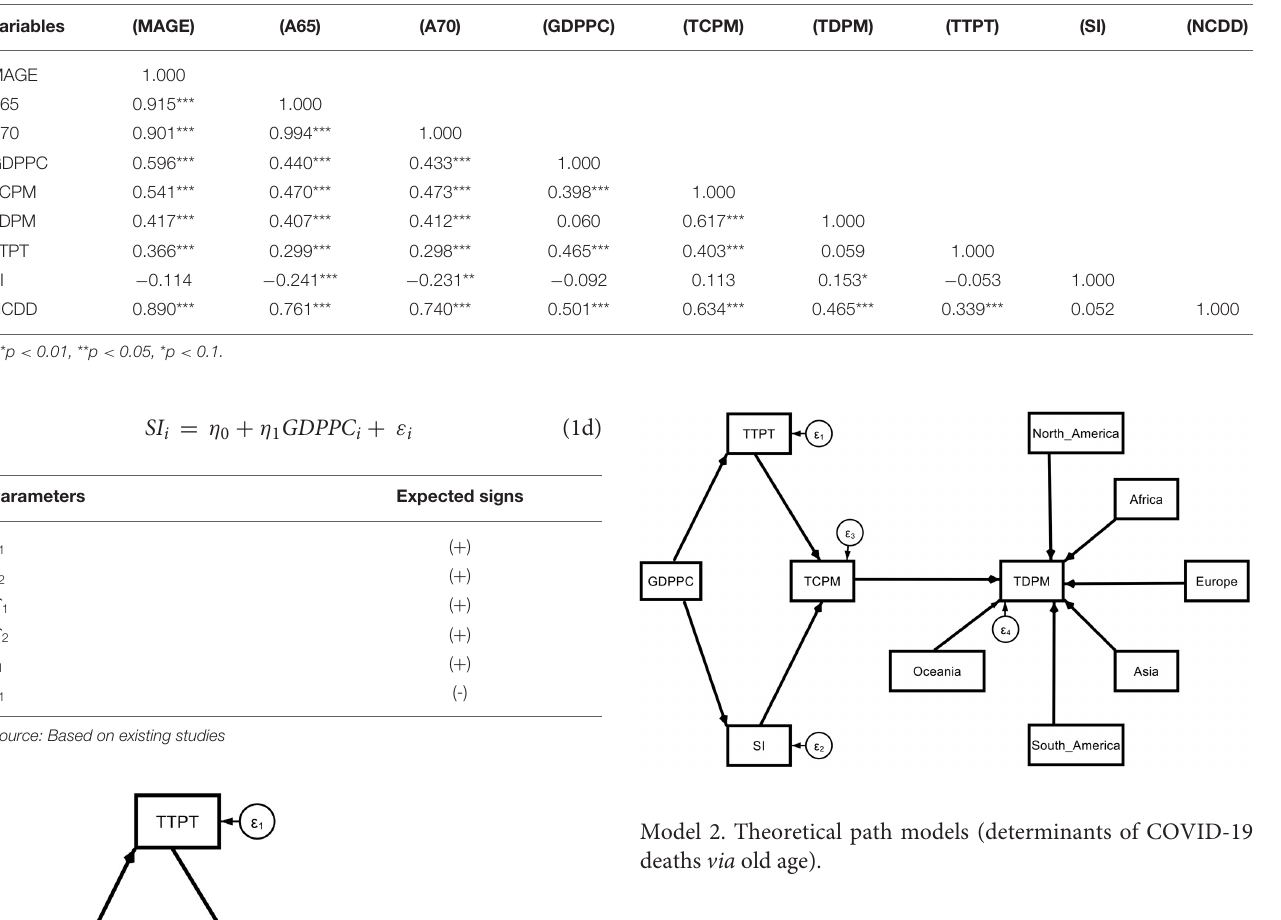
TABLE 4 | Spearman rank correlation coefficients.